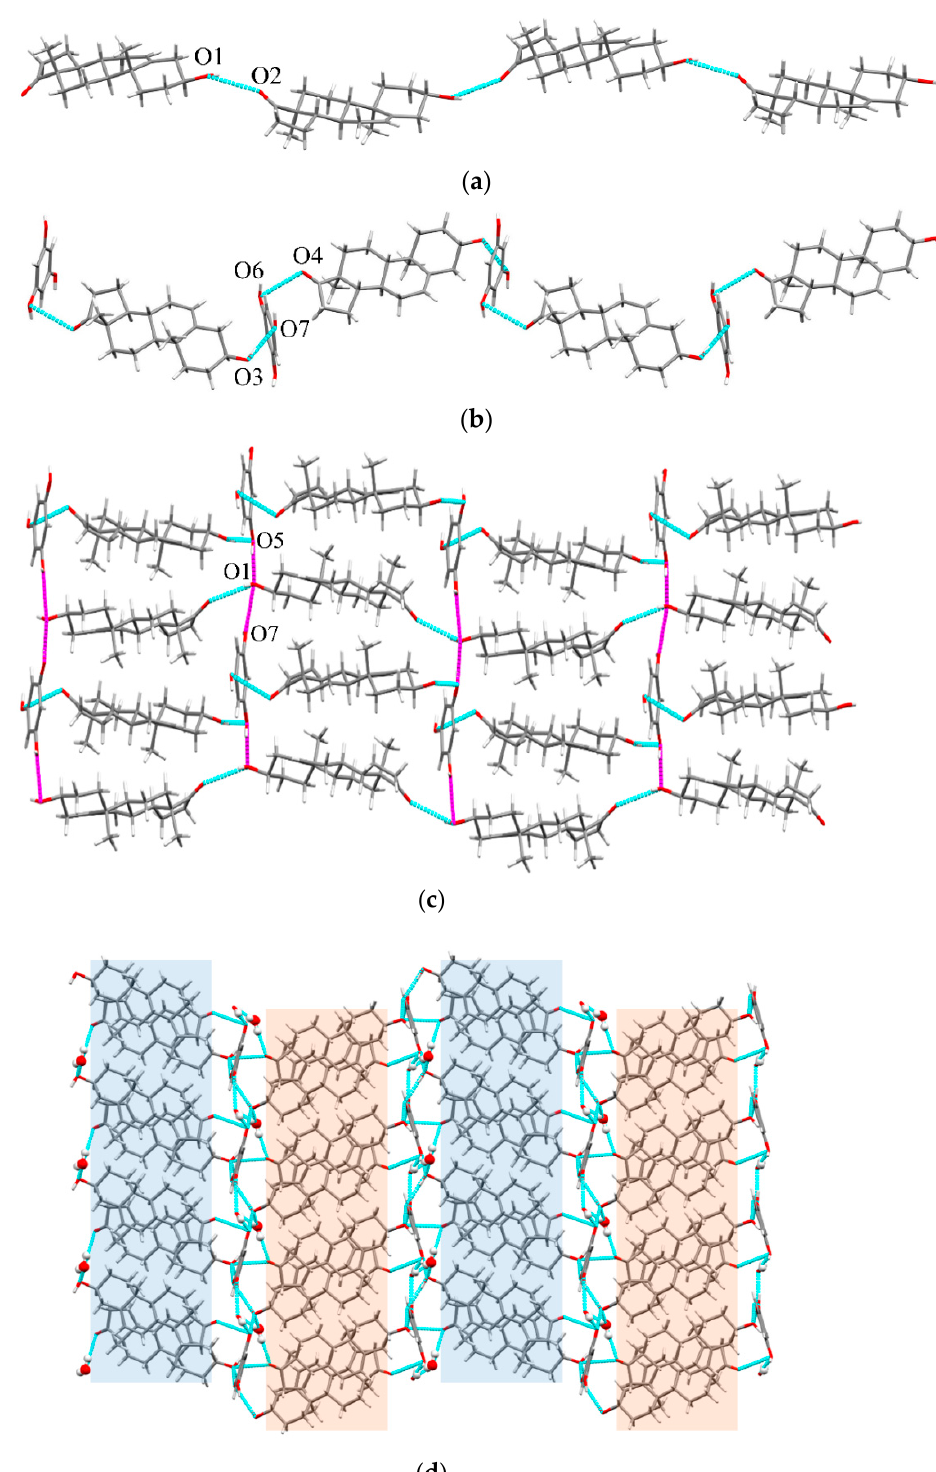
Figure 6. ( a , b ) 1D, ( c ) 2D, and ( d ) 3D supramolecular interactions of DHEA-PG-DH. DHEA-GA cocrystal (2:1). The crystal structure belongs to the monoclinic P 2 1 space group with DHEA and GA in 2:1 stoichiometry. Six hydrogen-bonds were formed for every GA molecule (O6-H6A···O3 (2.630 Å), O1-H1···O5 (2.763 Å), O9-H9A···O2 (2.706 Å), O7-H7···O4 (2.721 Å), O3-H3···O8 (2.984 Å) and O8-H8A···O1 (2.726 Å)) as shown in Figure 7a. No more hydrogen bonding is needed to form the final 2D supramolecular structure, where an 𝑅 (cid:2872) (cid:2872) (10) supramolecular heterosynthon was found to be an essential linker through O8-H8A···O1 (2.726 Å), O1-H1···O5 (2.763 Å), O6-H6A···O3 (2.630 Å), and O3- H3···O8 (2.984 Å) hydrogen bonding interactions (Figure 7b). Interestingly, distinct hy- drophilic GA and hydrophobic DHEA areas are alternatively aligned.